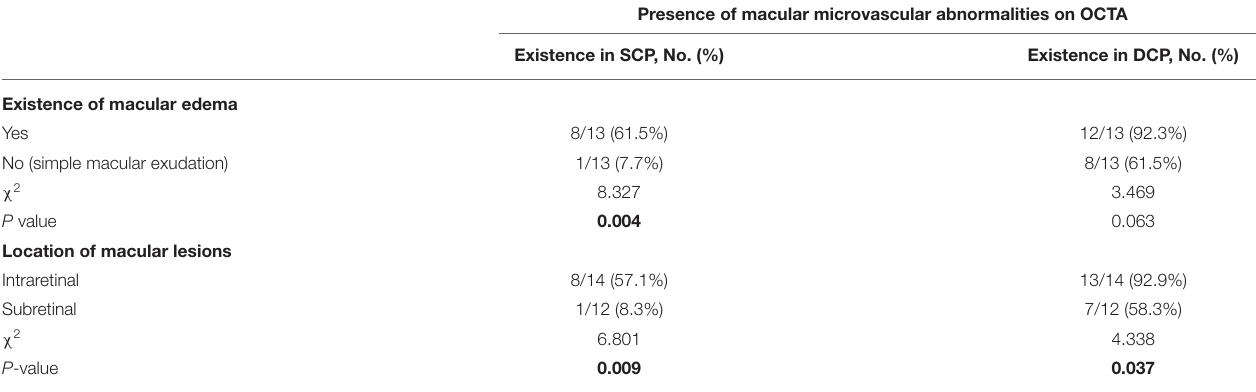
TABLE 2 | The morphological abnormalities of macular microvasculature in eyes with macular edema or exudation secondary to Coats’ disease. Presence of macular microvascular abnormalities on OCTA Existence in SCP, No. (%)